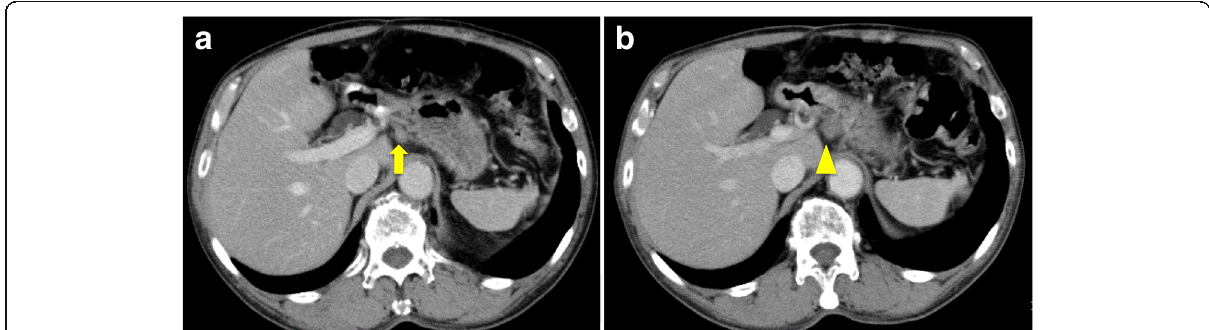
Fig. 1 An abdominal contrast-enhanced computed tomography a before endoscopic submucosal dissection (ESD) and b 1.5 months after ESD. a Abdominal contrast-enhanced computed tomography shows a nodule lesion with slight contrast near the remnant stomach (arrow). b The nodule lesion increased in size over 3 months (arrow